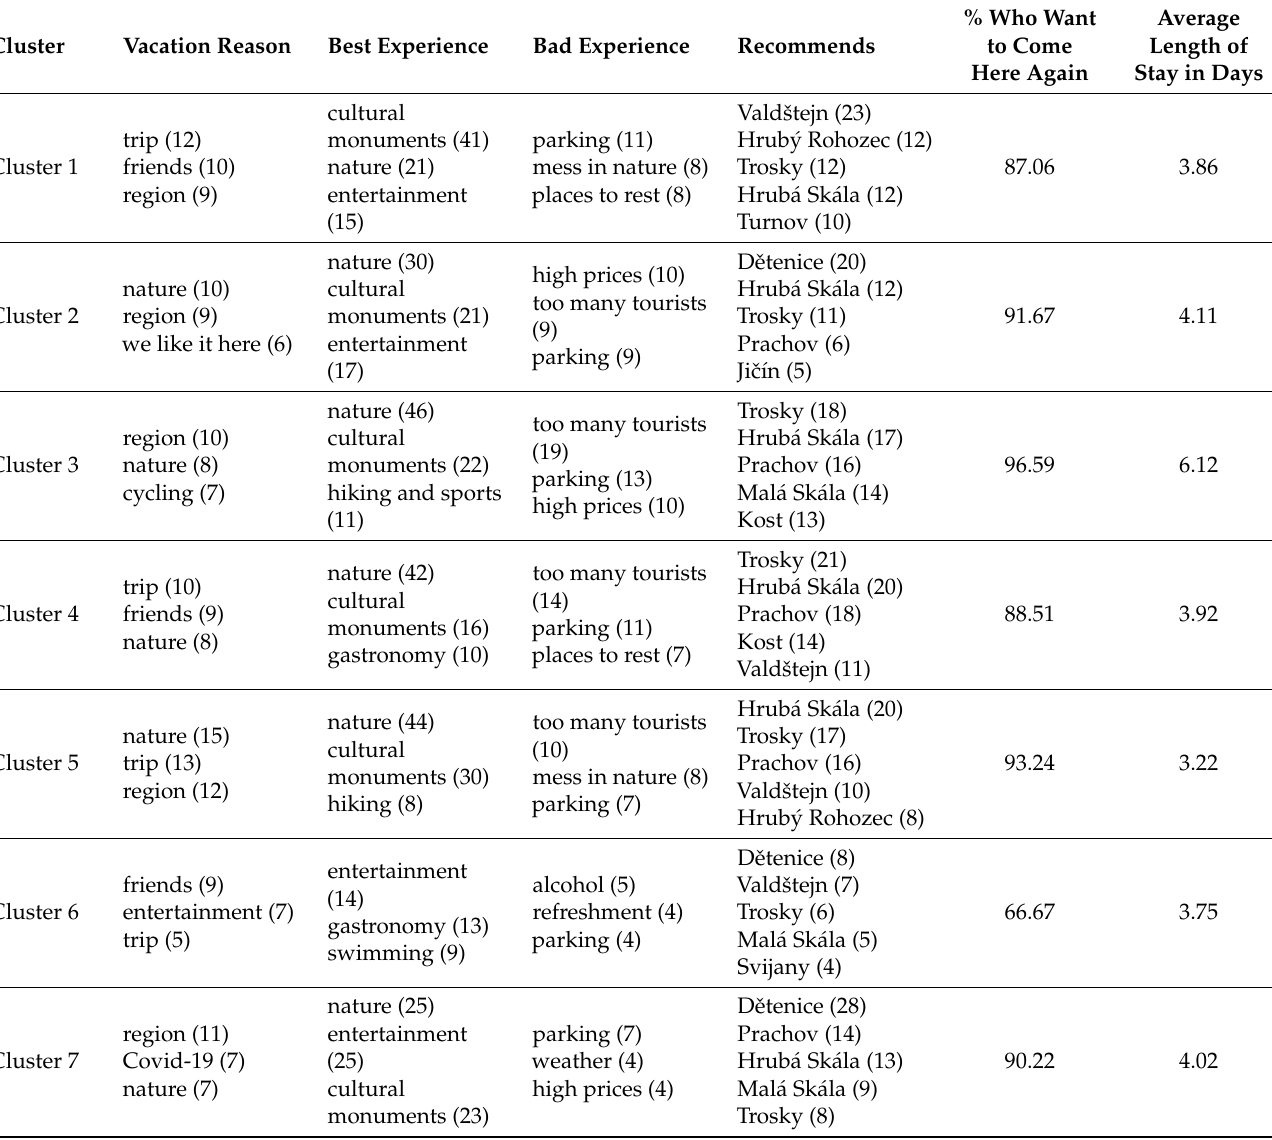
Table 2. Qualitative information on individual